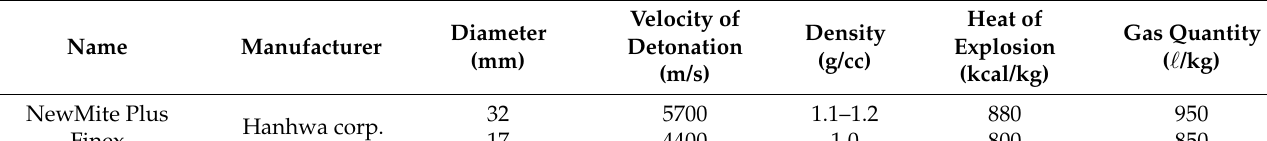
Table 4. Specification of used explosives.